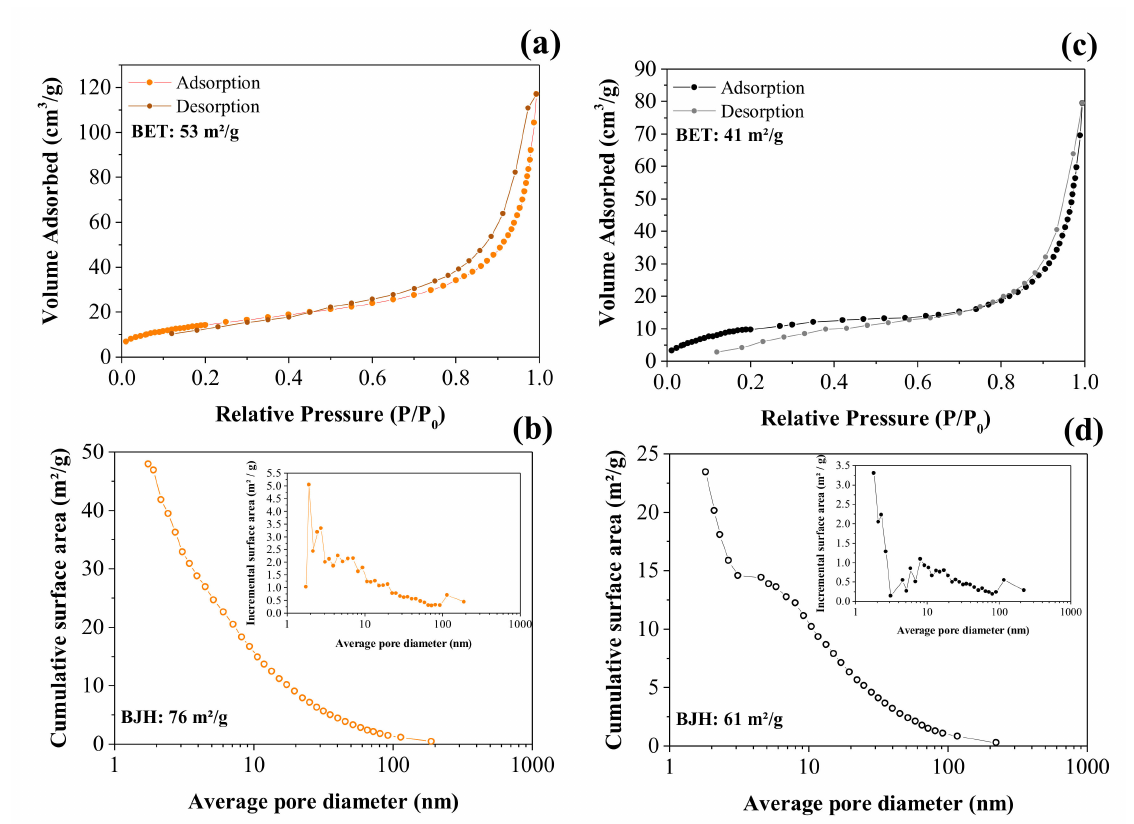
Figure 5. BET and BJH analyses of the adsorption/desorption nitrogen isotherm curves obtained for the CNFs ( a , b ) and NiO@CNFs ( c , d